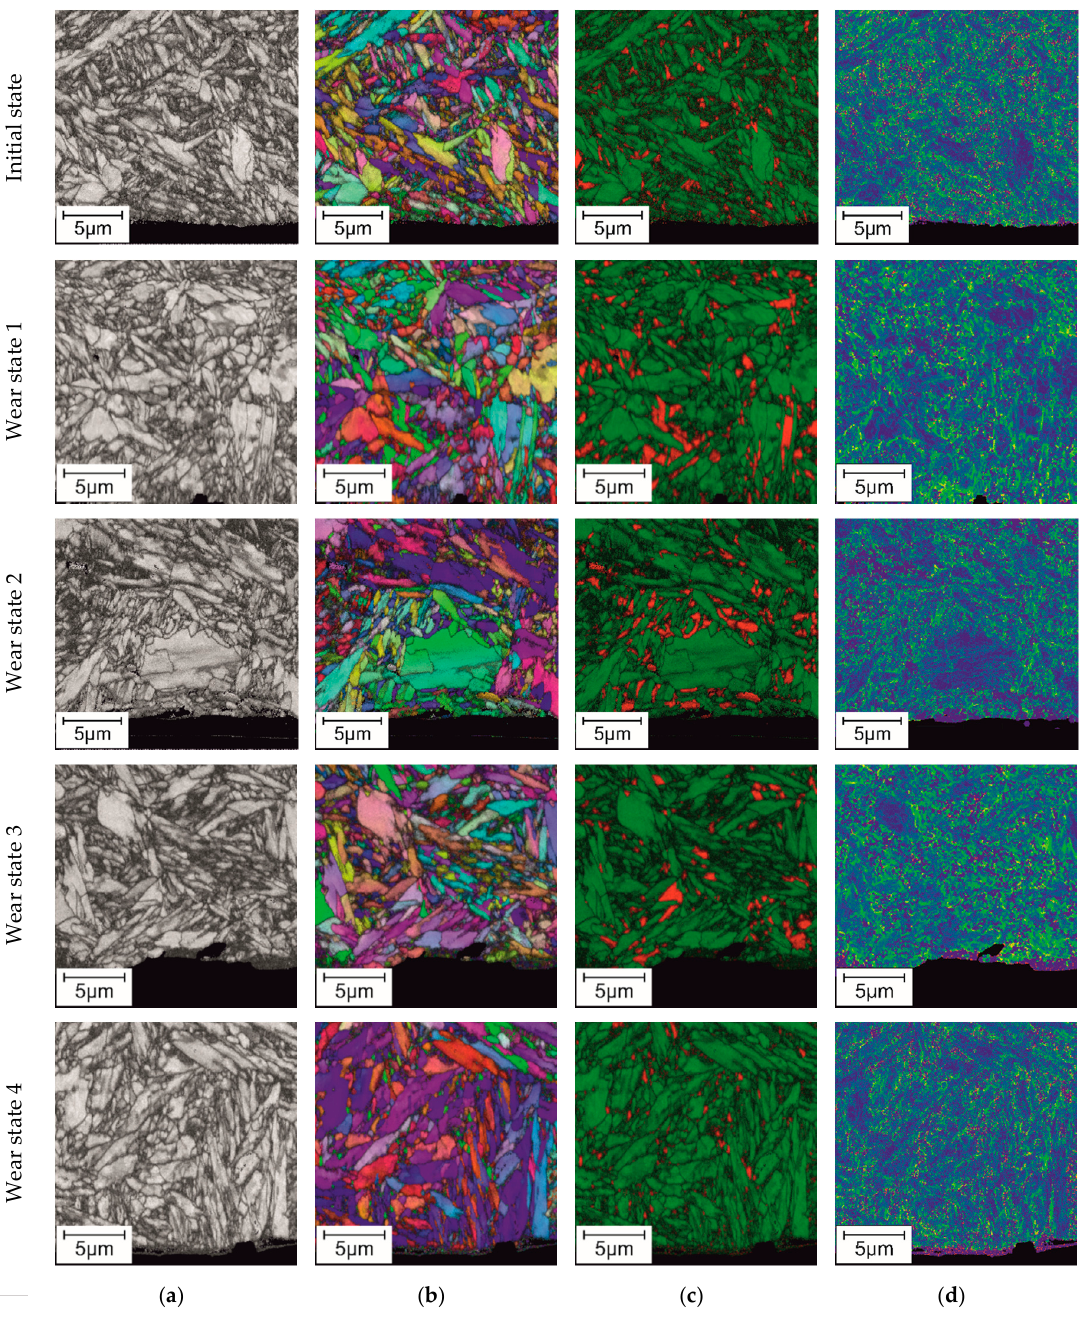
Figure 9. EBSD on cross-sections of gear teeth (surface is shown at the bottom): ( a ) Fit map; ( b ) Inverse Pole Figure (IPF) map; ( c ) Phase map: green: bcc-lattice (martensite), red: fcc-lattice (austenite); ( d ) Kernel Average Misorientation (KAM) respect the first neighbor: blue: minimum misorientation, red: maximum misorientation.